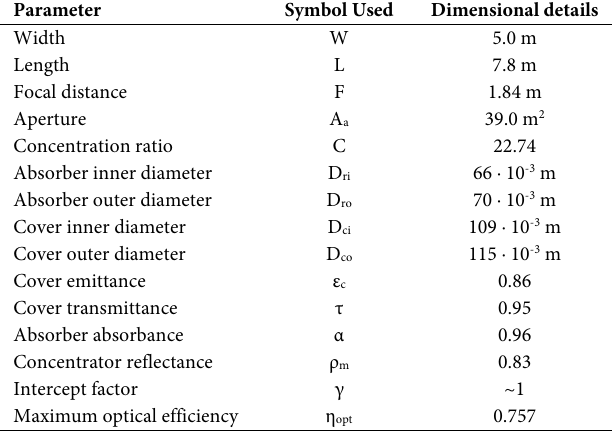
Table 1. Technical specifications of the PTC system for thermal modeling